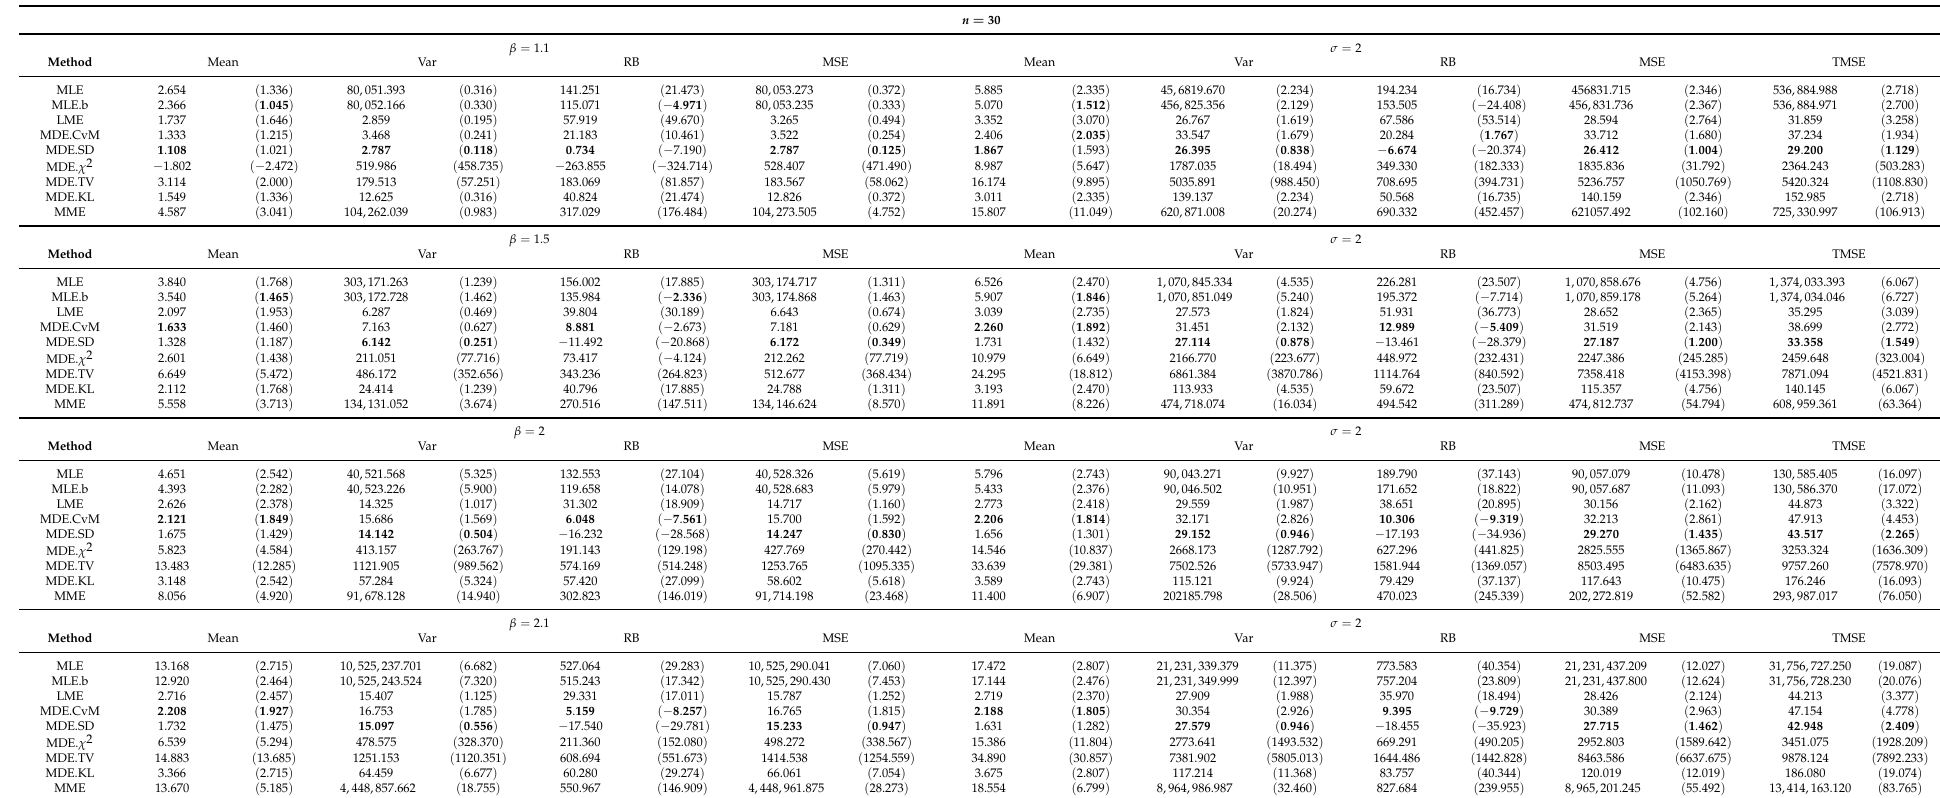
Table 2. Comparison of different estimation methods for different values of β ( σ = 2 and n =